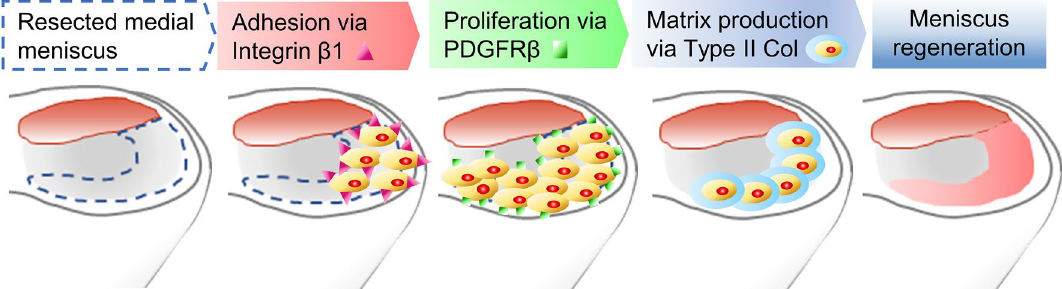
Figure 4. Summary. Synovial MSCs injected into the knee joint adhered to the area around the meniscectomized region via integrin β1, proliferated via PDGFRβ, produced cartilage matrix by type II collagen, and promoted meniscus